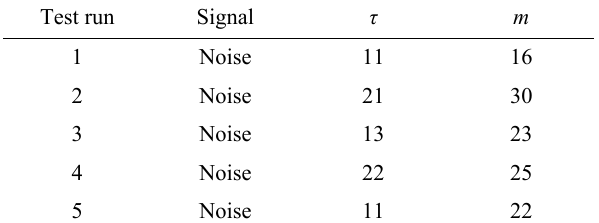
Table 2 Embedding dimensions and delay times of friction noise signals.